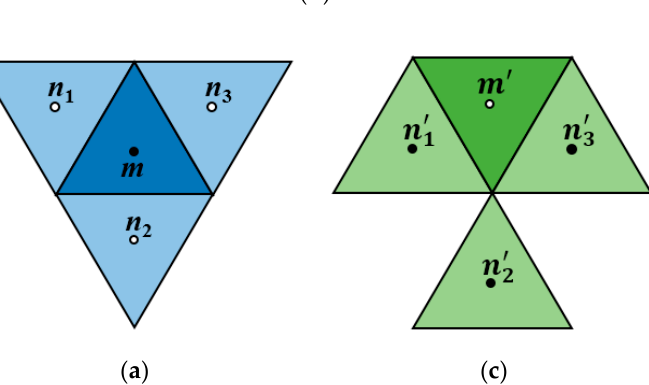
. ( c ) The result of the translation: (cid:3117)